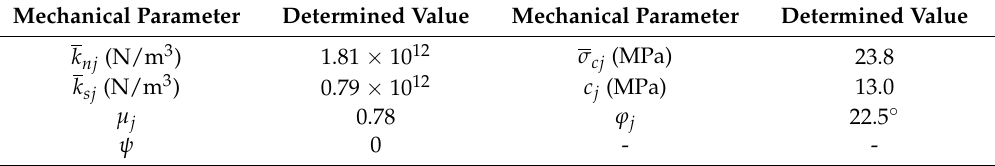
Table 3. Mechanical parameter values used for the smooth joint model.